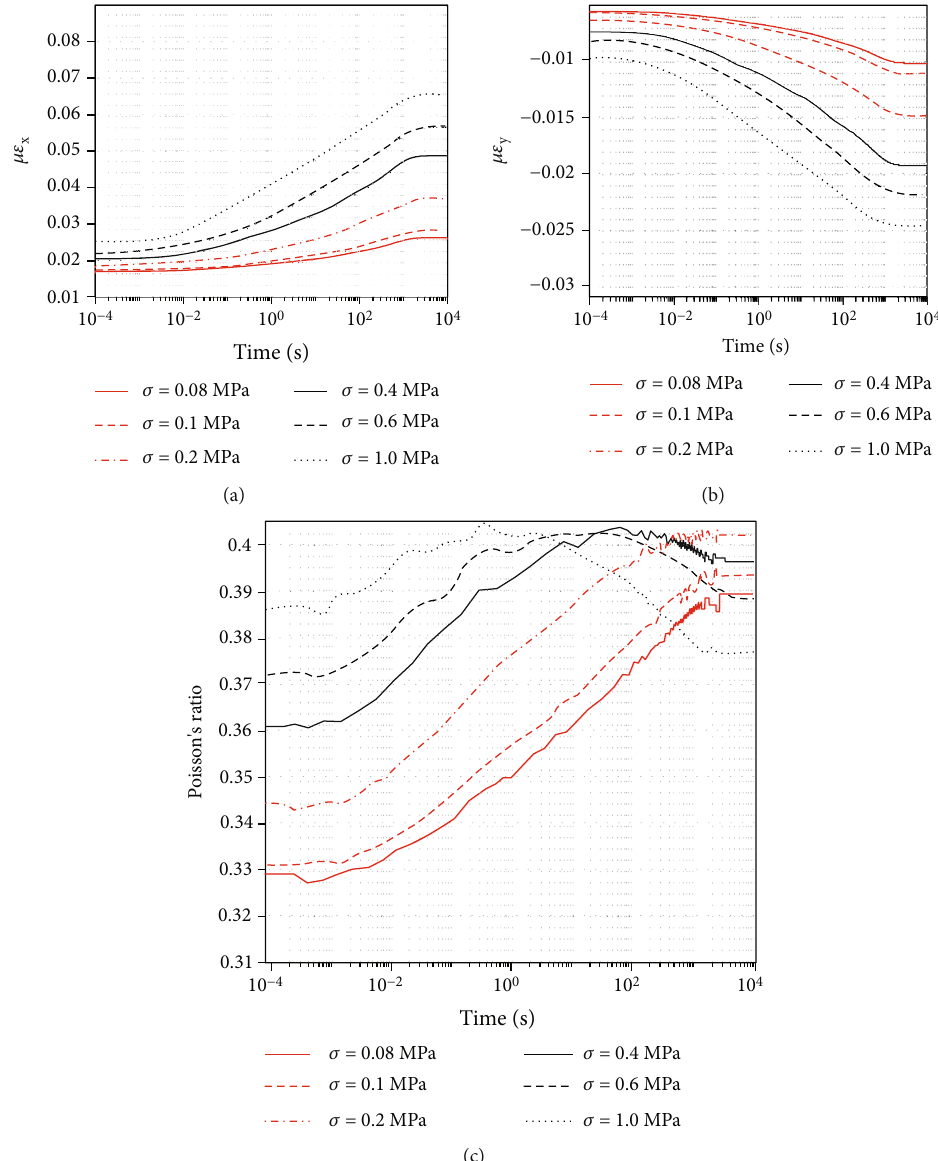
Figure 9: The curves of the (a) longitudinal strain, (b) transverse strain, and (c) Poisson ’ s ratio versus time under di ff erent cohesive